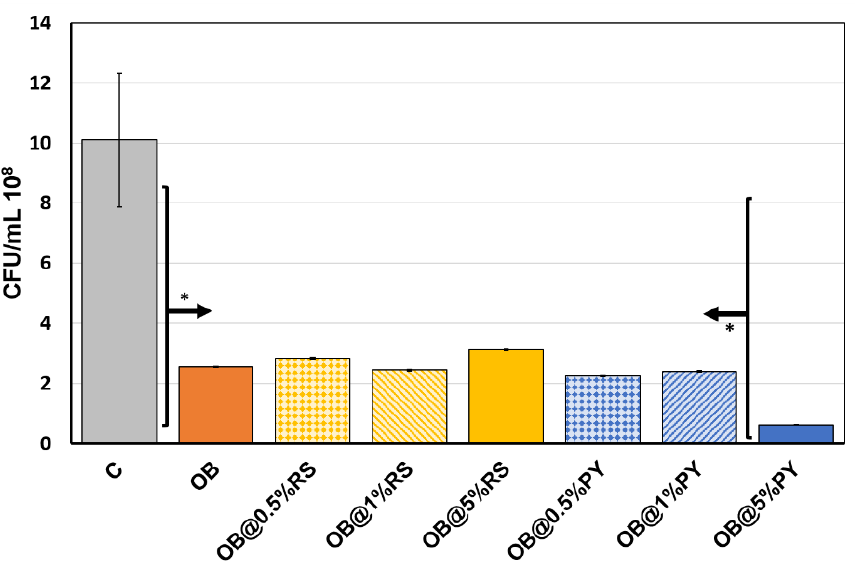
Figure 2. Number of colony forming units/mL of E. faecalis in the presence of sealer (OB) and sealer + different concentrations of RS/PY after 24 h of culture. C represents the control CFU experiment, without any material in each case. * p < 0.05.